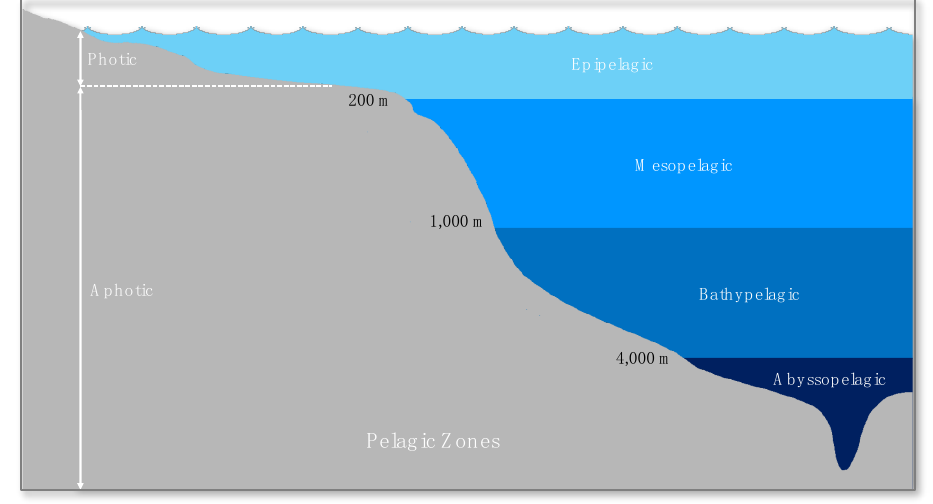
Figure 1. Oceanographic pelagic zones.